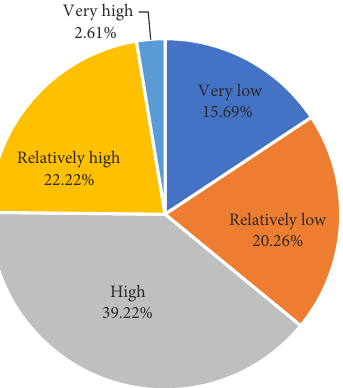
Figure 5. Statistical chart of BIM application degree of respondents